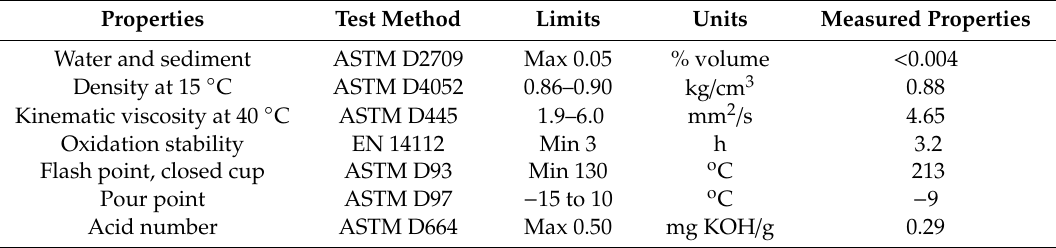
Table 6. Physicochemical characterization of TERI (OE) R-983